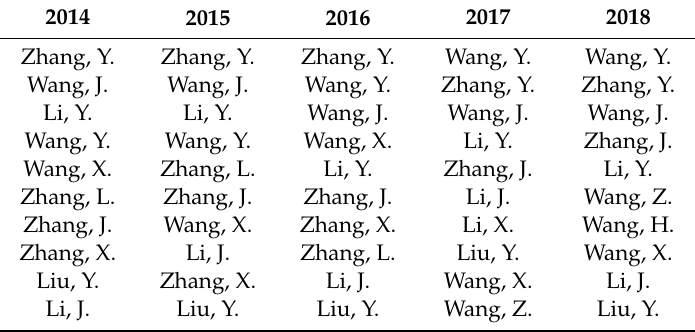
Figure 4. The statistical indicators of degree centrality curve during 2014–2018. Table 2. The core authors of each year.